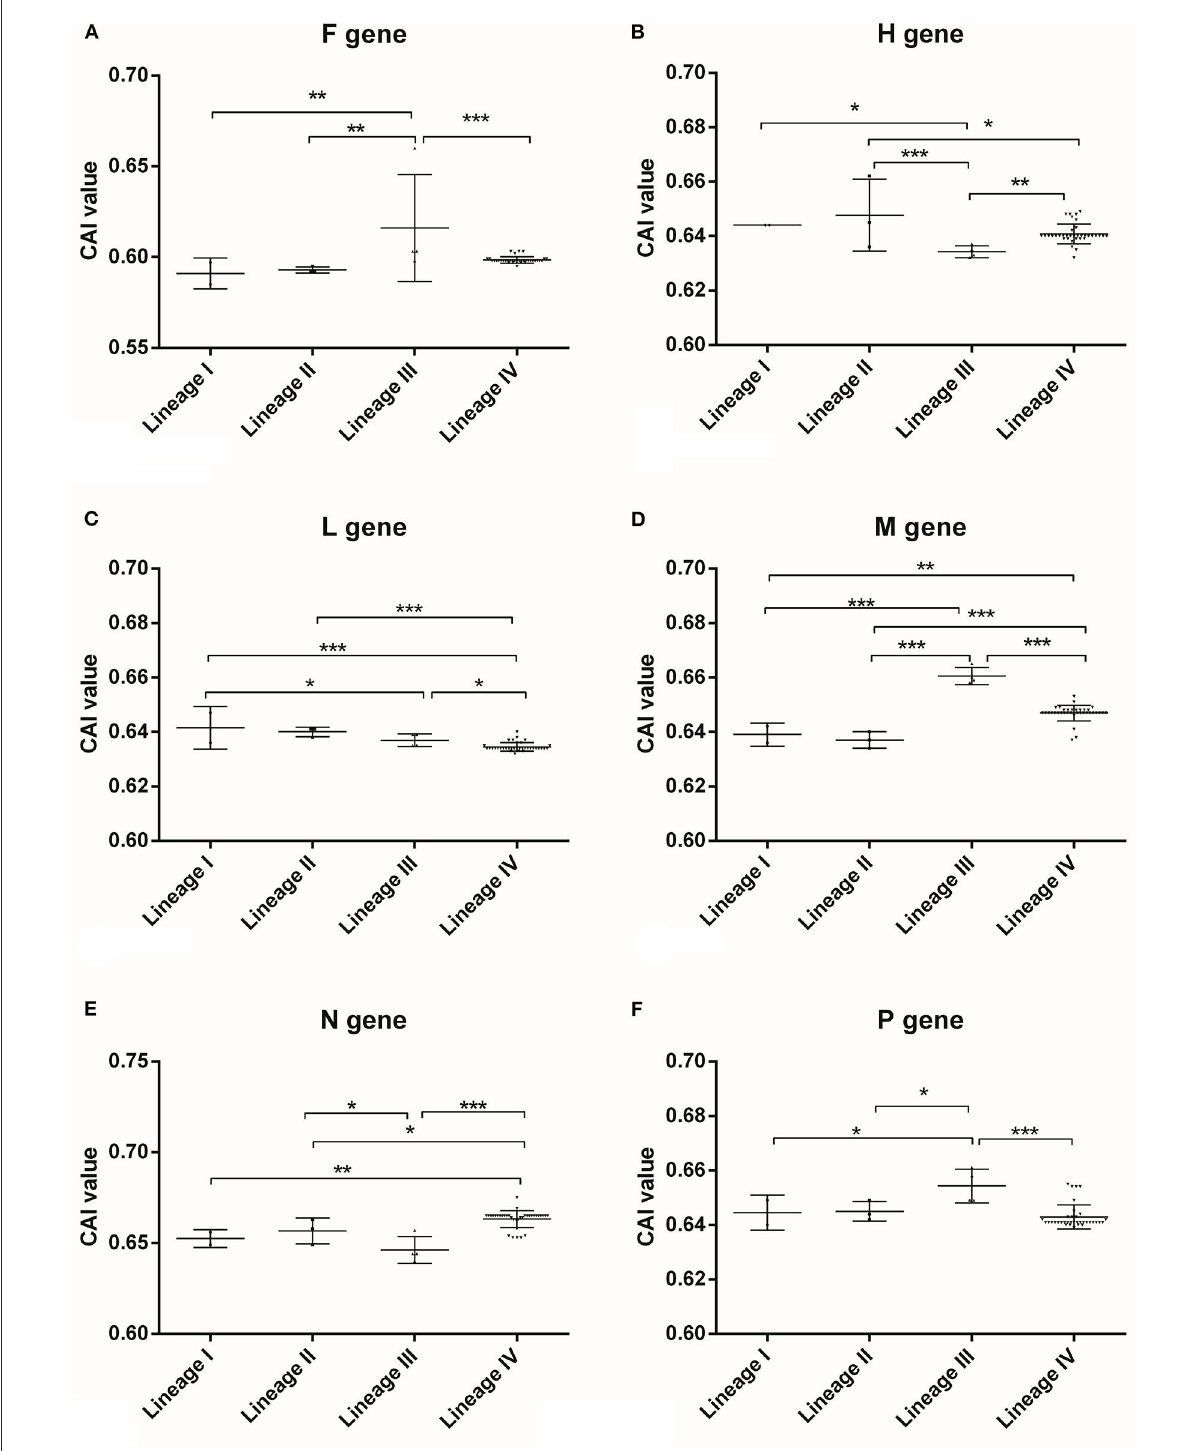
FIGURE4 CAI analysis for PPRV coding sequences of different lineages in relation to its host performed by CAIcal server. CAI is frequently used as a measure of gene expression and to assess the adaptation of viral genes to their hosts, which indicates the influence of natural selection. The higher CAI value is, the more adaptation of synonymous codon usage of the target coding sequence is to its host. (A) F gene, (B) H gene, (C) L gene, (D) M gene, (E) N gene, (F) P gene. “*” means significant difference between the two different lineages with p -value < 0.05 performed by One-way ANOVA method, “**” means significant difference between the two different lineages with p -value < 0.01 performed by One-way ANOVA method, “***” means significant difference between the two different lineages with p -value < 0.001 performed by One-way ANOVA